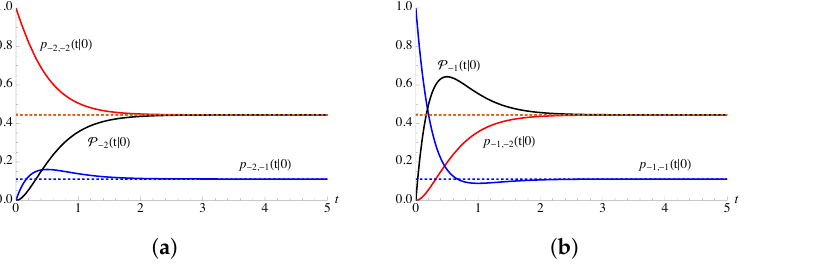
Figure 3. As in Figure 2, for ϕ ( t ) = 1 and for ξ = 1.0, (cid:36) = 1.0, ν = 4.0. In ( a ) j = − 2 (failure state) and in ( b ) j = − 1 (repair state).